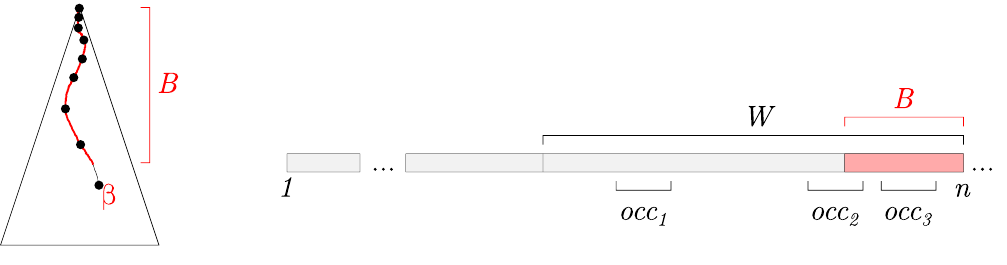
Figure 2. On the left: Illustration of partially constructed suffix tree T with implicit buffer B and active node β . On the right: Illustration of the stream, the sliding window W , the implicit buffer B , and three cases for positions of the query strings occ 1 , occ 2 , and occ 3